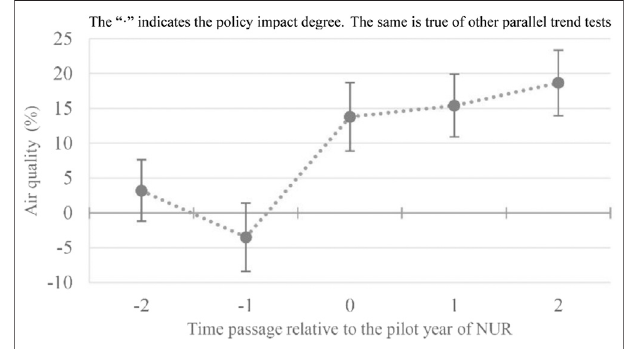
FIGURE 5 | The parallel trend test for the air quality.